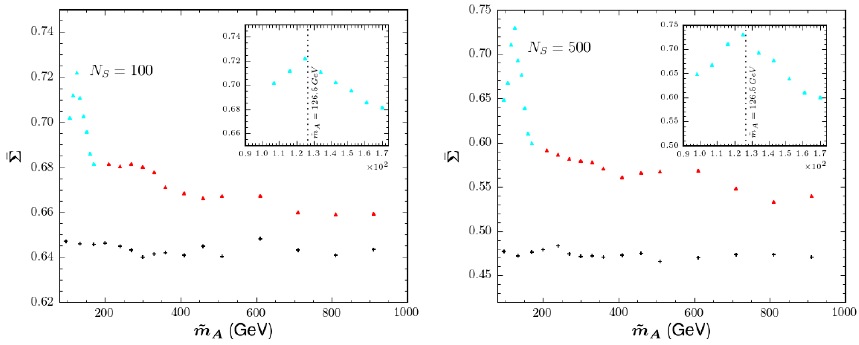
Figure 28 . The same as (cid:12)gure 25, but for signal events where particles D are pair-produced and decay as in (cid:12)gure 1. The left (right) panel is made with 100 (500) signal events.